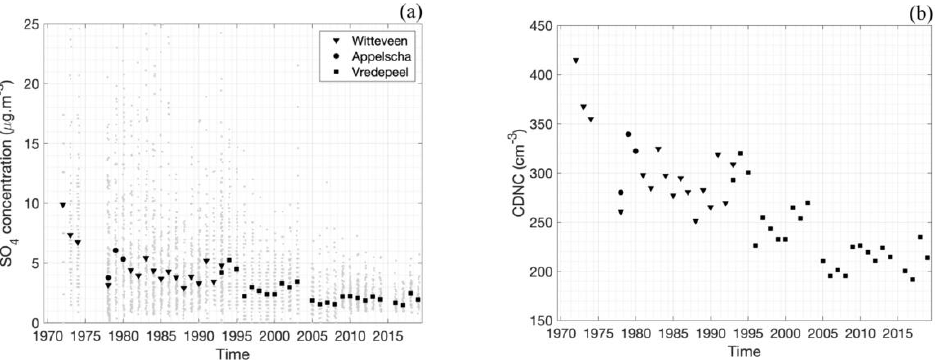
Figure 3. ( a ) Time series of non-sea-salt (nss) sulfate mass concentration observed over the Nether- lands during the summer season (June–August) from three sites (Witteveen, triangles; Appelscha, dots; Vredepeel, squares; see supplementary material for more details). The black signs correspond to the median over the summer season and the grey signs to the daily averages. ( b ) Time series of CDNC derived from the Boucher and Lohmann relationship [22] applied to the nss-sulfate concentration shown in Figure 3a.